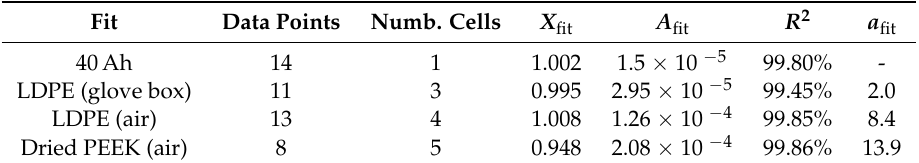
fit R 2 . Data points refer to the number of points used to fit the data. The first data point is neglected for all cell